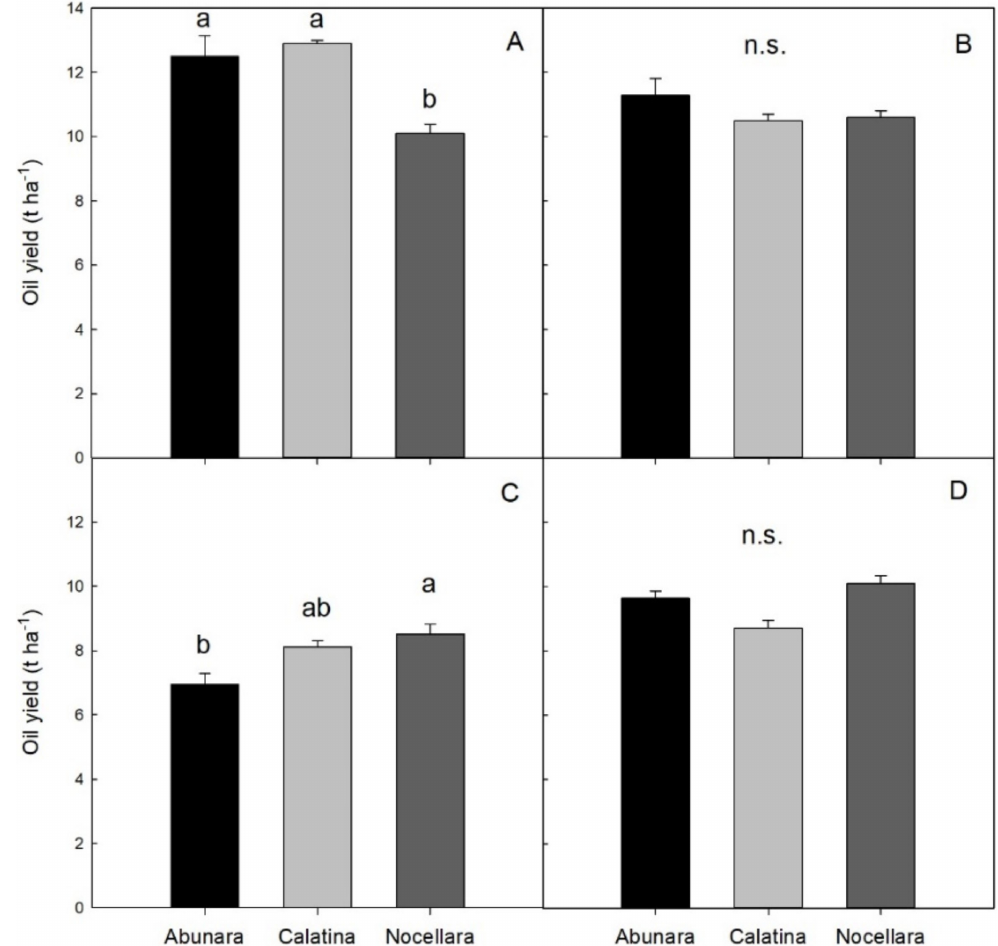
Figure 7. Cumulated oil yield per hectare across the seven years of trial for ‘Abunara’, ‘Calatina’, and ‘Nocellara del Belice’ olive trees grown as central leaders at 2 × 5 m (CLx2, ( A )), free palmette at 3 × 5 m (FPx3, ( B )), globe vase at 4 × 5 m (GVx4, ( C )), and polyconic vase at 5 × 5 m (PVx5, ( D )). Error bars represent standard errors of the means. Mean separation by Tukey’s honestly significant difference (HSD, p < 0.05). Different letters indicate significant differences among cultivars and within each planting system; n.s.,